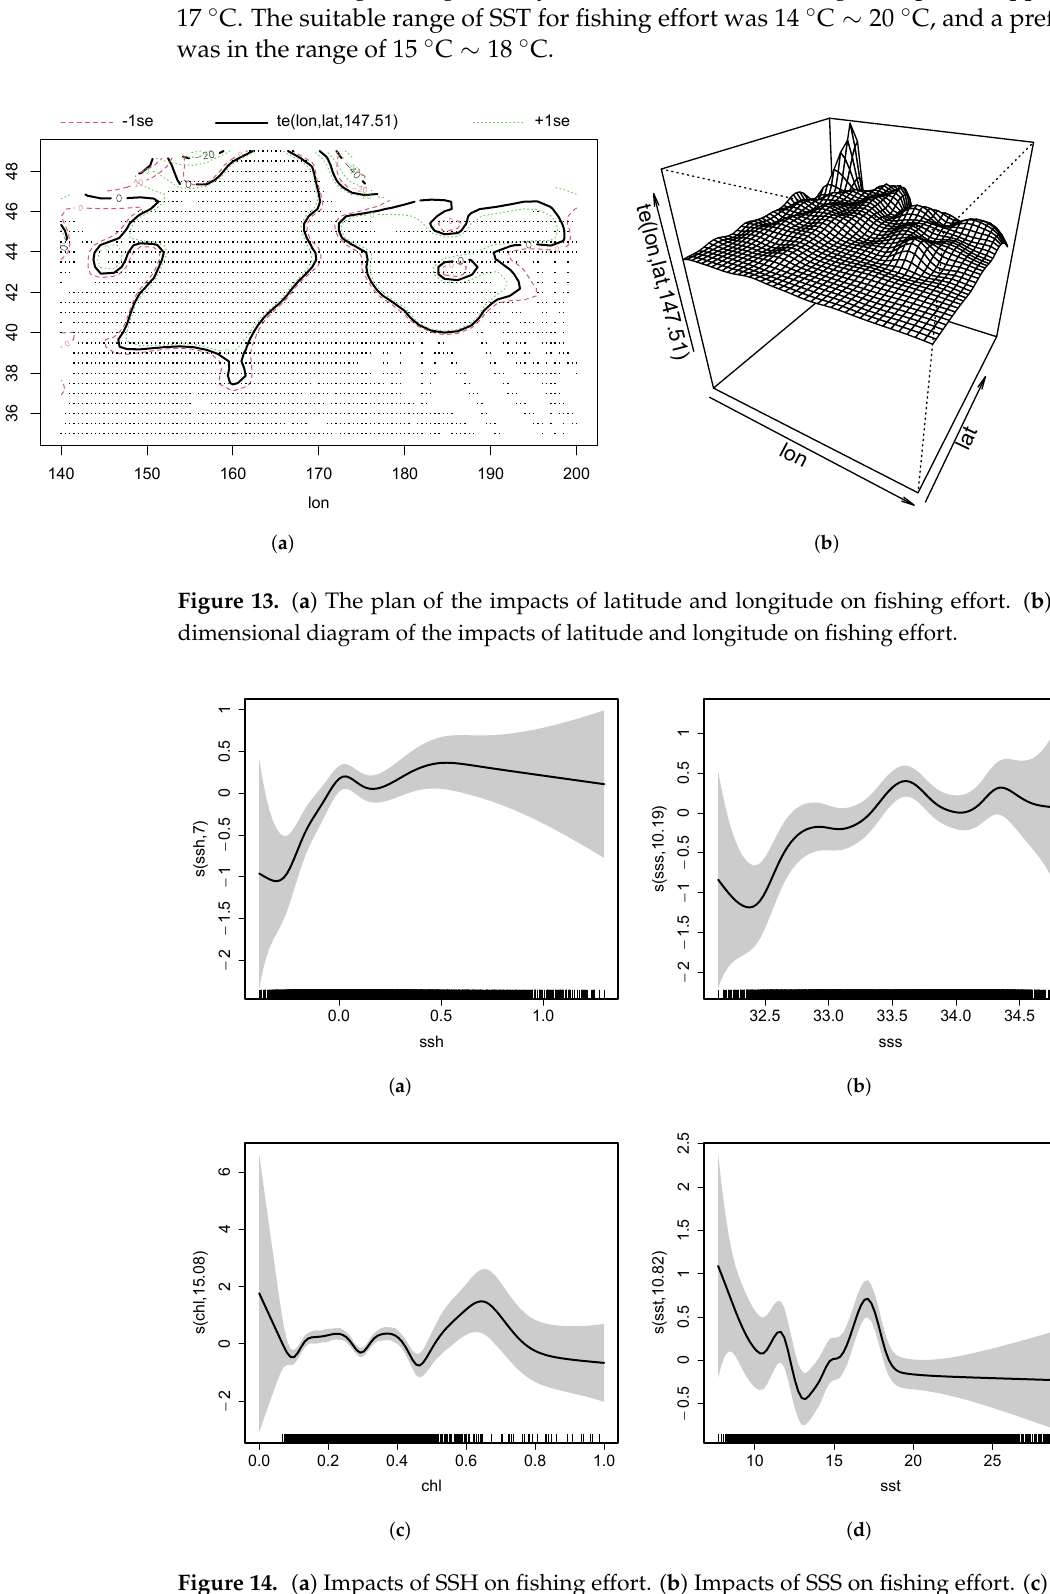
Figure 14. ( a ) Impacts of SSH on fishing effort. ( b ) Impacts of SSS on fishing effort. ( c ) Impacts of Chla on fishing effort. ( d ) Impacts of SST on fishing